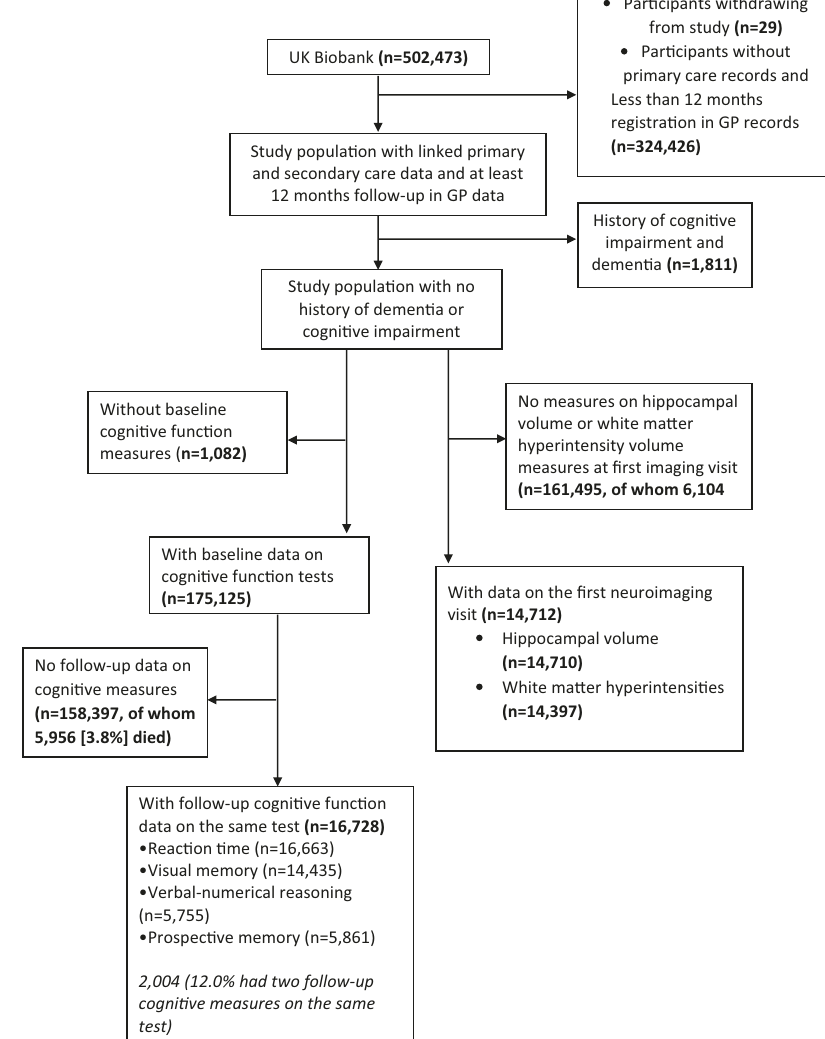
Fig. 1 Flow chart of study population. Flowchart depicting participants included and excluded from this